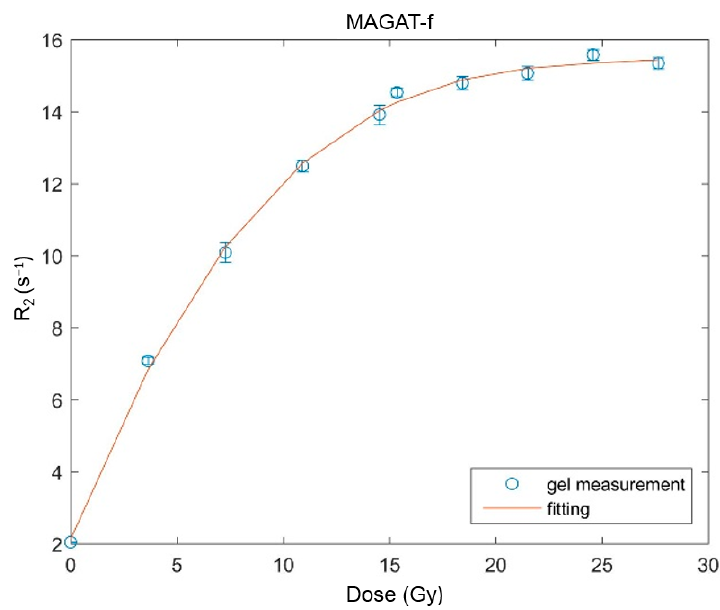
Figure 2. Dose–response curve of MAGAT-f gel dosimeter.